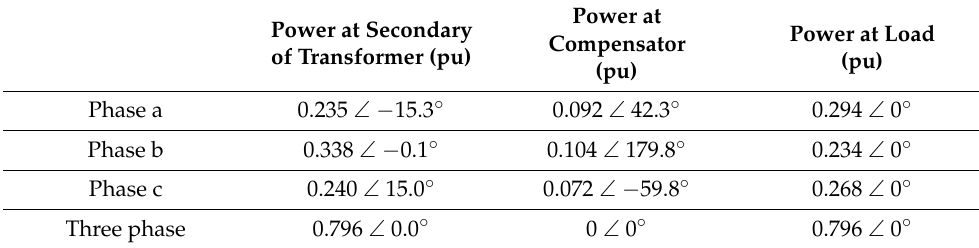
Table 6. Apparent power at transformer, compensator, and load in Case B. Power Power at Secondary of Transformer (pu)